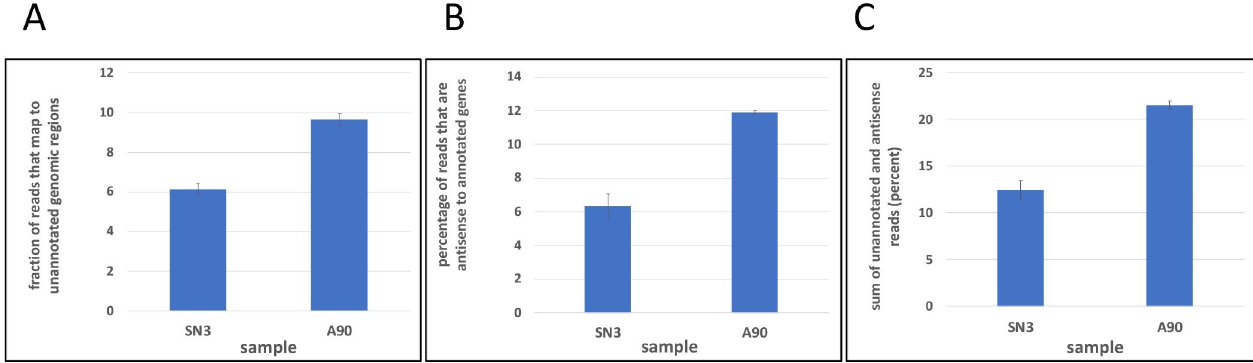
Fig 5. Fraction of all mapped reads that map outside of or antisense to annotated genes. Fraction (represented as percentages) of all mapped reads that map outside of or antisense to annotated genes. SN3 –untreated control cells. A90 –cells treated with 90 nM AN3661. Error bars denote standard deviations calculated from the values in each replicate of the respective sample. A. Reads that map outside of annotated regions. B. Reads that map antisense to annotated genes. C. Sum of data shown in panels A and B.